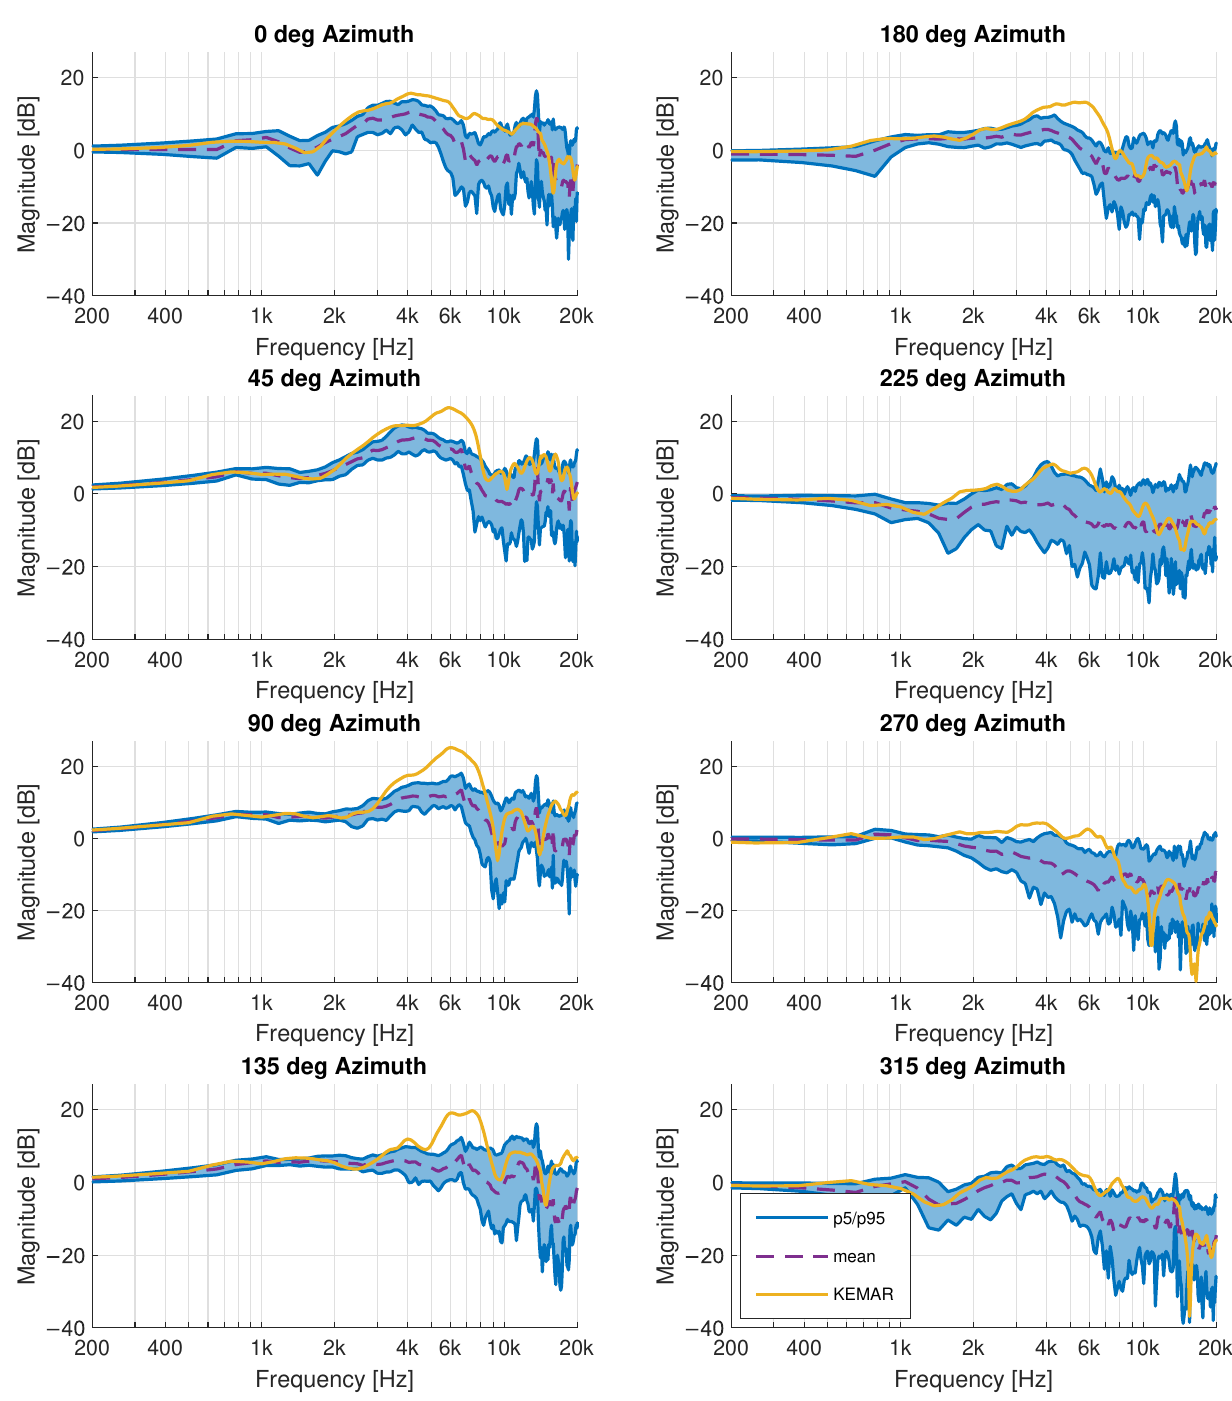
Figure 7. Horizontal plane HRTF comparison between the measured children dataset and the KEMAR artificial head. The 5th and 95th percentile (p5/p95) in the children database are shown in